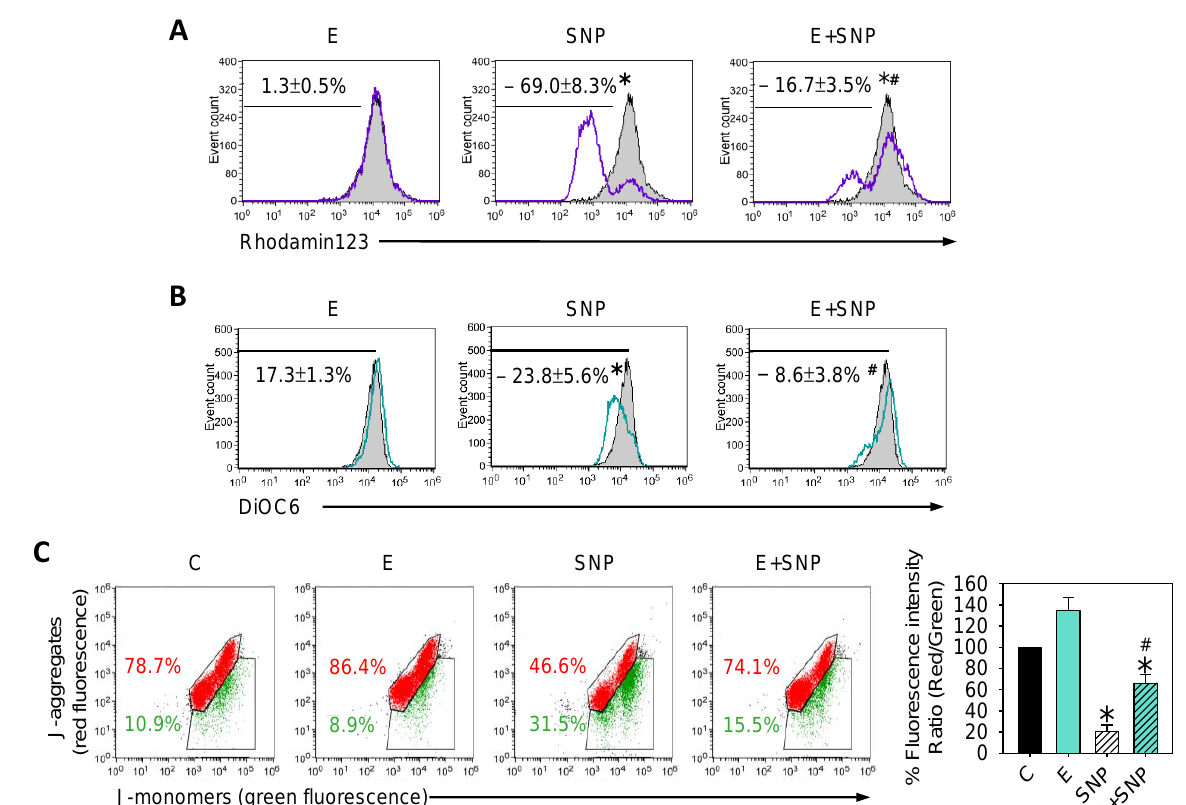
Figure 3. The effect of SNP and/or S-Equol on the mitochondrial membrane potential (ΔΨM) of primary chondrocytes. After cells were treated with S-Equol for 24 h in the presence or absence of SNP for another 24 h, ΔΨM was determined by ( A ) Rhodamin123, ( B ) DiOC6, or ( C ) JC-1 staining, respectively, followed by flow cytometry. The gray filled area is the untreated control, and those delimited by the purple or green lines are the treated groups. In non-damaged cells with high ΔΨM, JC-1 spontaneously forms complexes known as J-aggregates (red fluorescence), whereas in unhealthy cells with low ΔΨM, JC-1 remains in the monomeric form (green fluorescence). The results are expressed as the mean ± S.D. for three separate experiments. * p < 0.05 compared to the untreated control. # p < 0.05 compared to the corresponding SNP-treated group.